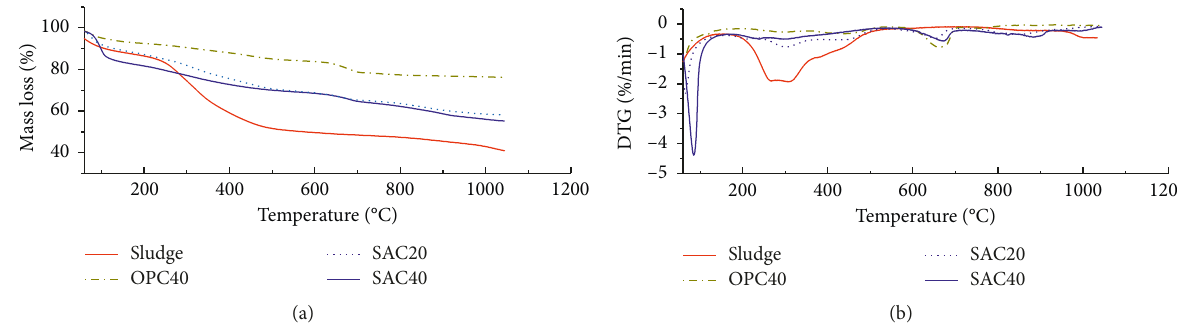
Figure 9: TGA curves after 7-day